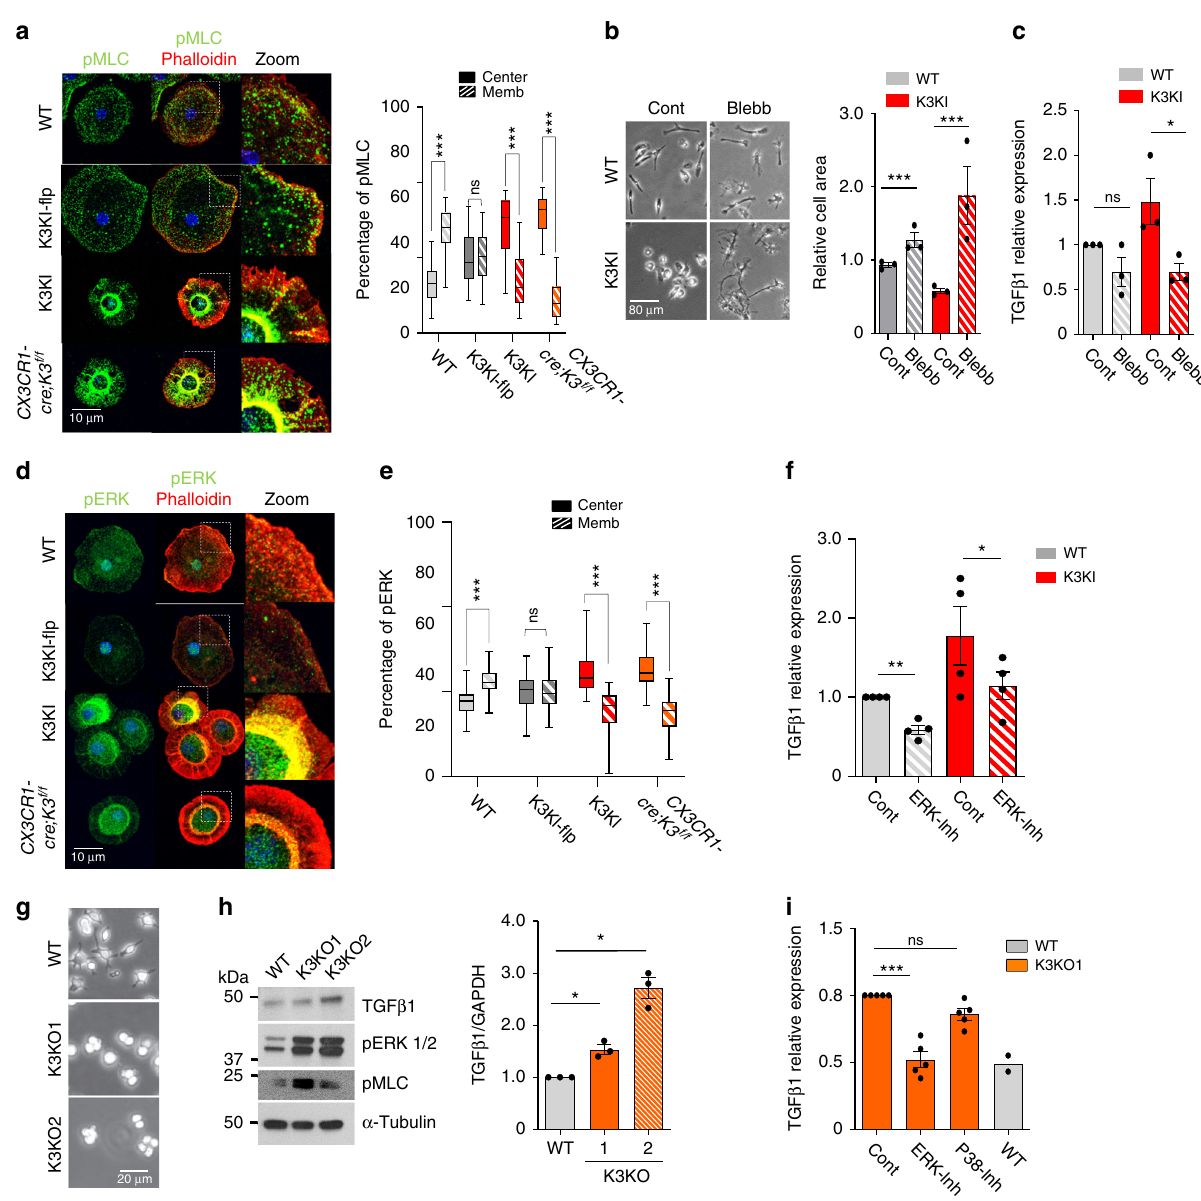
Fig. 7 Kindlin3 de fi ciency leads to mislocalization of myosin light chain II and increased ERK activation. a Immunostaining of primary microglial cells for phosho-myosin light chain II (pMLC) and Actin (phalloidin). The z-planes of confocal microscopy images were stacked to produce a superimposed image. An enlarged view of the cell edge shows co-localization of pMLC and actin to the membrane. The bar graph shows the proportion of pMLC localized either to the membrane (outer one-third area) or center (inner two-third area) of the cell (two-tailed t -test; P < 0.0001 (***), P = 0.7780 (ns); N = 35 cells from three experiments). b Phase-contrast image of microglia treated with DMSO (control) or 50 µ M blebbistatin (Blebb) and spread on fi bronectin-coated plates for 12 h. Bar graph shows cell spread area relative to WT control (two-tailed t -test; P < 0.0001 (***); N = 3 experiments). c QPCR analysis for TGF β 1 in control vs. blebbistatin-treated microglia (two-tailed t -test; P = 0.0684 (ns); P = 0.0234 (*), N = 3 experiments). d Immunostaining of microglia for phospho-ERK1/2 (pERK) (green) counterstained with phalloidin for actin (red) and DAPI for nuclei (blue). e The bar graphs show the proportion of pERK localized to membrane or the cell center (two-tailed t -test; P < 0.0001 (***), P = 0.7535 (ns); N = 40 cells from three experiments). f TGF β 1 mRNA levels assessed by QPCR in WT and K3KI microglia treated with vehicle (Control) or ERK inhibitor (U0126) (one-tailed t -test; P = 0.0028 (**), P = 0.0307 (*); N = 4 experiments). g Representative phase-contrast images of WT and the two clones of Kindlin3 knockout RAW cells, K3KO1 and K3KO2, spread on fi bronectin-coated plates from fi ve independent experiments. h Western blot analysis of WT and K3KO RAW cell lysates for TGF β 1, p-ERK1/2, and pMLC. Equal protein loading is shown by α -tubulin. The bar graph shows TGF β 1 levels (one-way ANOVA with Dunnett ’ s post hoc; P WT- K3KO1 = 0.0406 (*), P WT- = 0.0205 (*); N = 3 experiments). i TGF β 1 mRNA levels as assessed by QPCR in K3KO cells treated with vehicle, (U0126) and P38 inhibitor K3KO2 (Sb20358) (one-way ANOVA with Dunnett ’ s post hoc; P < 0.0001 (***), P = 0.0543 (ns); N = 5 experiments). WT levels ( N = 2) are shown only for an estimated comparison. All bar graphs are represented as mean and error bars are